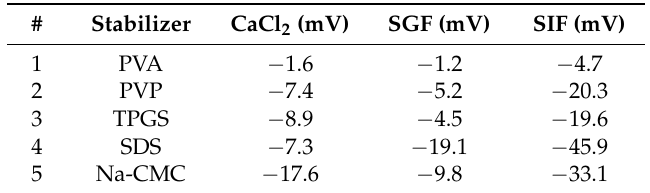
Table 1. Zeta potential values of curcumin nanosuspension stabilized with five different stabilizers after addition of CaCl2 solution (150 mM), simulated gastric fluid (SGF), and simulated intestinal fluid (SIF).